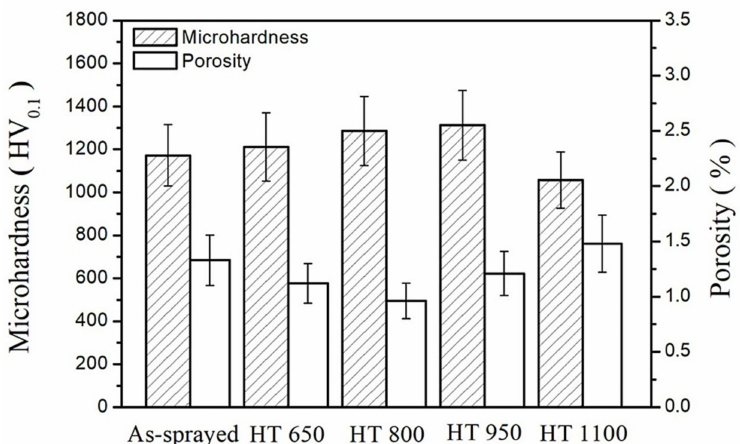
Figure 6. Vickers microhardness and porosity of as-sprayed and heat-treated WC–12Co